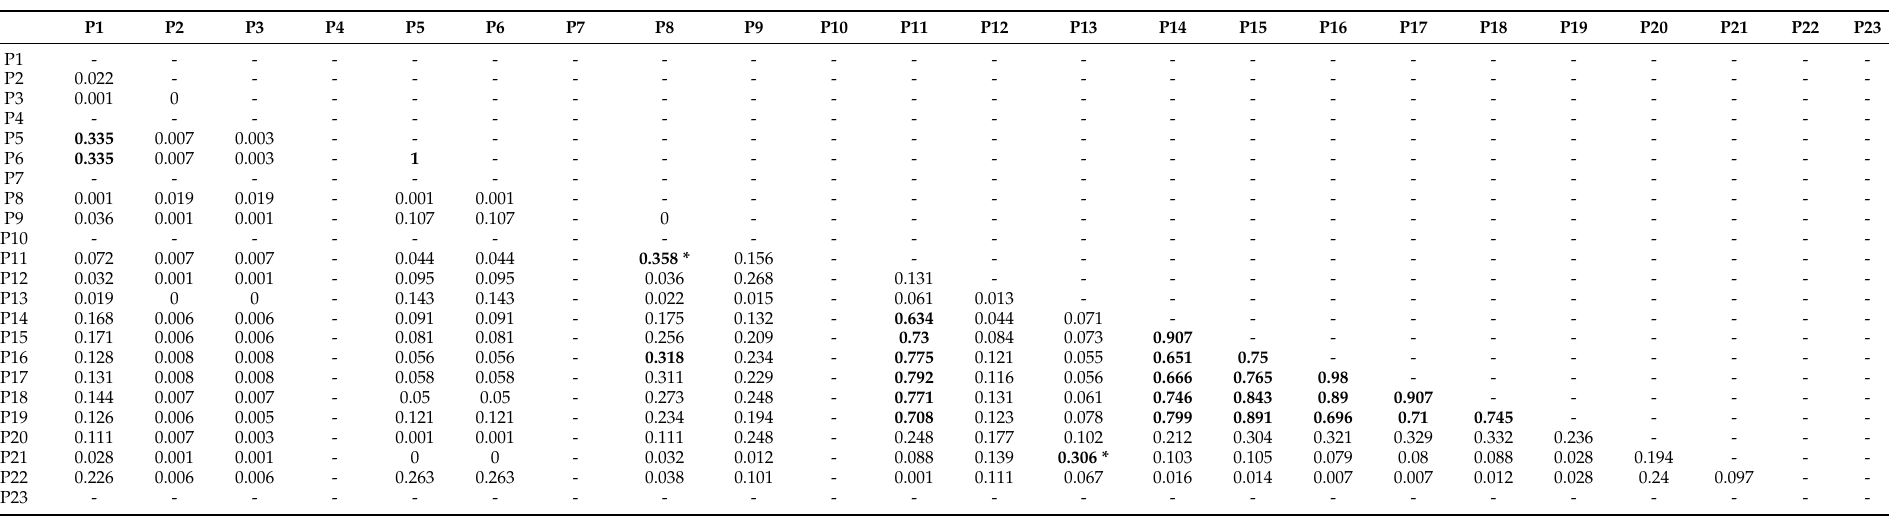
Table 3. Linkage disequilibrium (LD) scores among 23 polymorphisms of the bovine IFITM3 gene in Hanwoo.